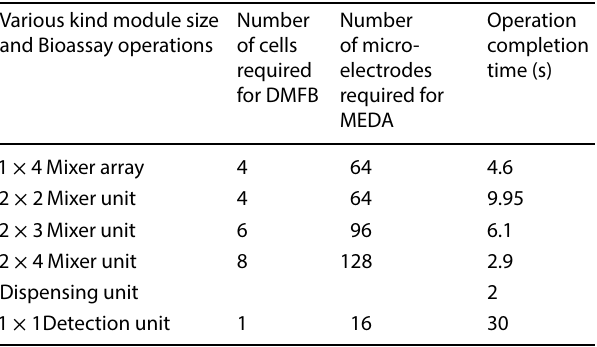
Number of cells